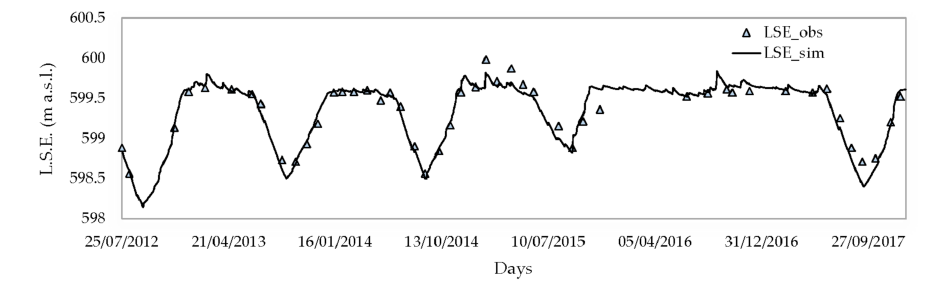
Figure 7. Observed and simulated surface elevation (LSE, m a.s.l.) of Lake Zazari for the calibration